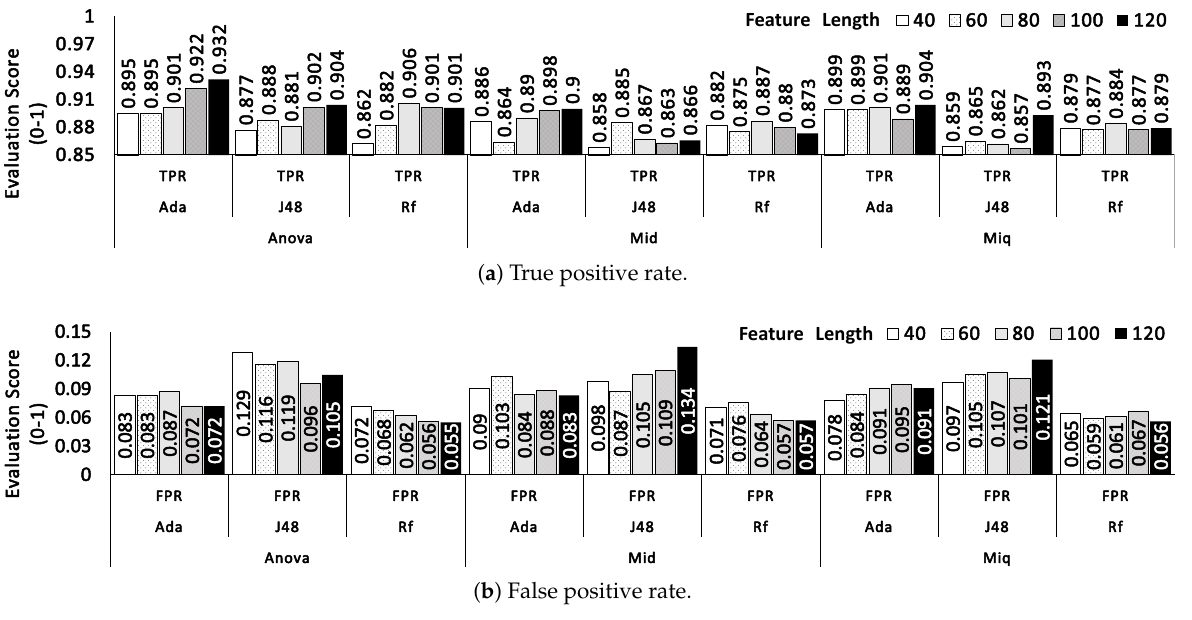
Figure 4. Performance of classifiers on mnemonic features.